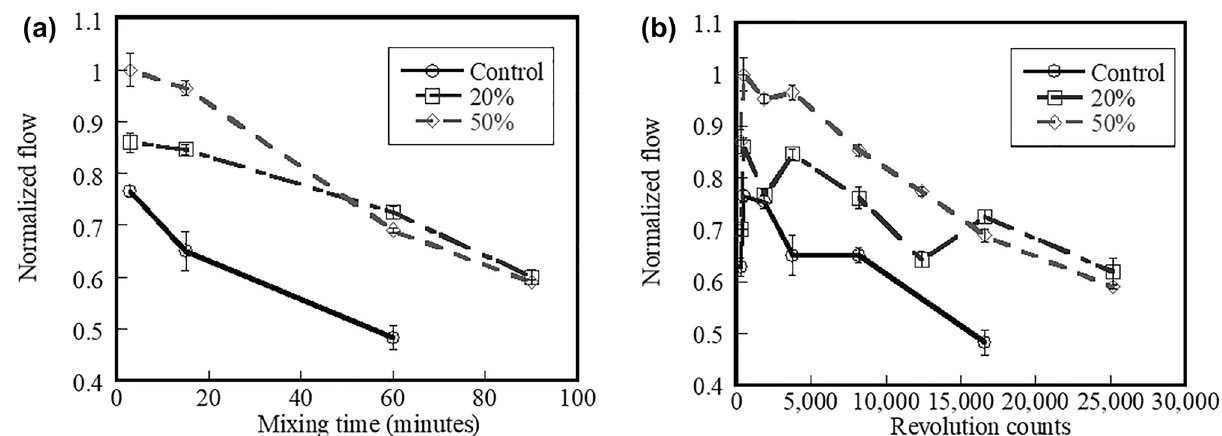
Figure 5. Effect of ( a ) mixing time and ( b ) mixer revolution counts on normalized flow of control system and systems containing 20% and 50% fly